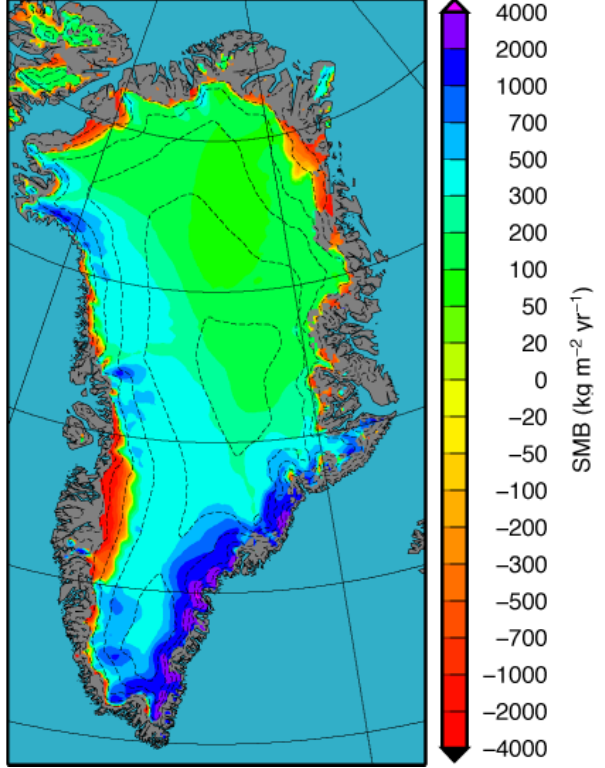
Fig. 1. SMB (1958–2007 average) over the GrIS (Ettema et al., 2009); dashed contour lines indicate surface elevation in 500m